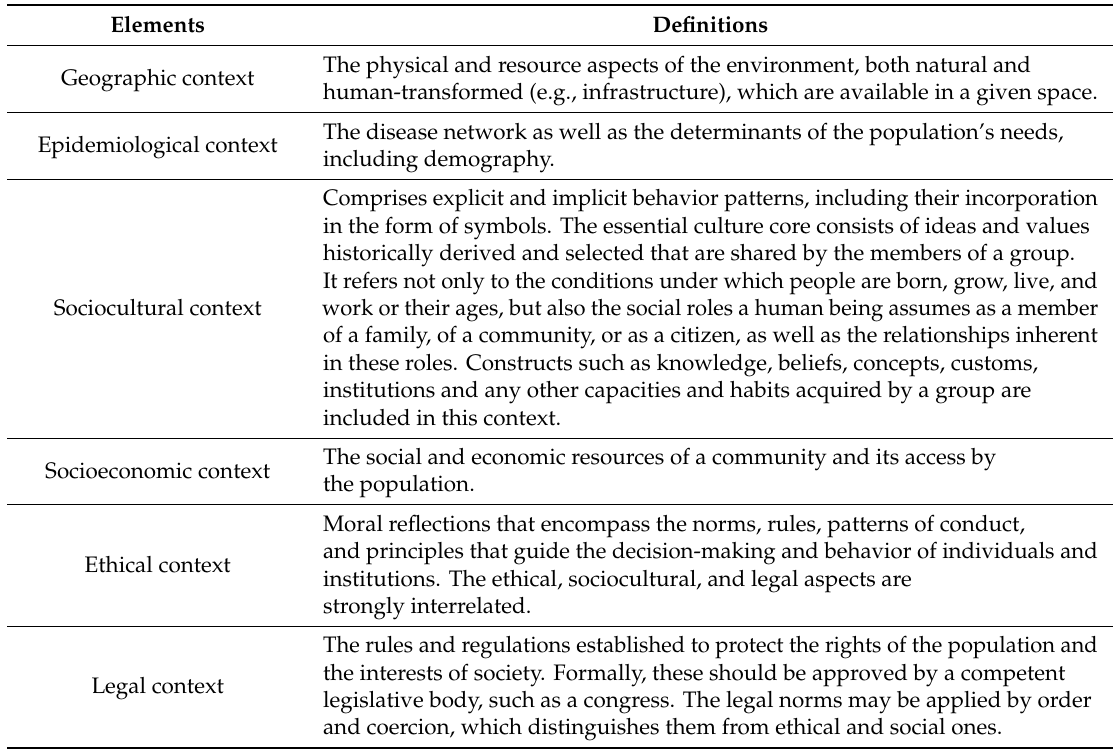
Table 3. Definitions of the CICI model categories (Pfadenhauer et al.,